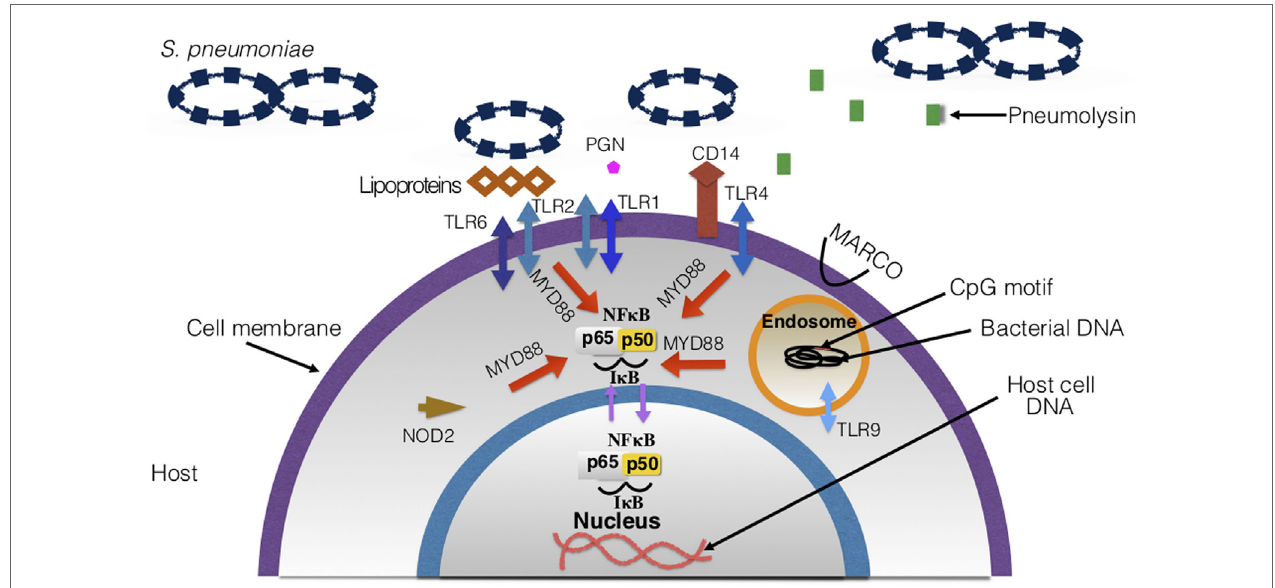
FigURe 7 | Host surface and intracellular receptors necessary for immune response to Streptococcus pneumoniae . Highlighted in this figure are the major pathogen recognition receptors necessary for binding to pneumococcal ligands and eliciting an immune response. Upon binding to the ligands, receptors and signaling pathways are activated, which leads to the overall production of inflammatory cytokines and recruitment of immune cells. There are 10 toll-like receptors (TLRs) that have been discovered in humans—TLRs involved in pneumococcal disease are depicted in the